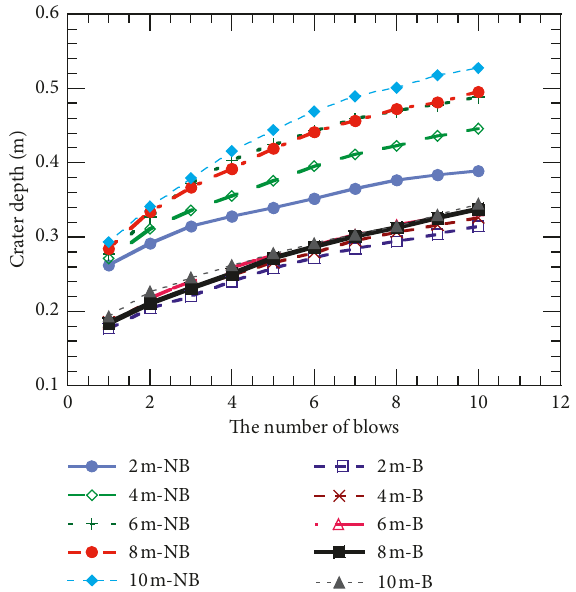
Figure 7: The crater depth under different dropping distances (NB means no particle breakage; B means particle